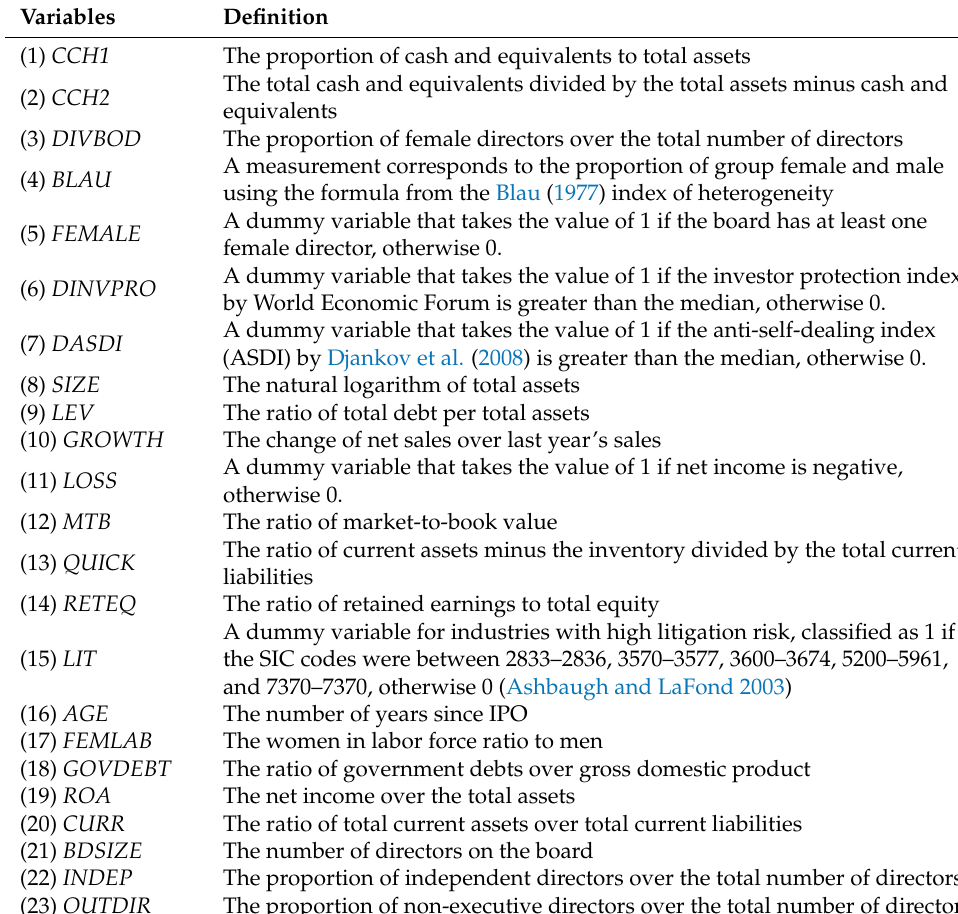
Table A1. Variable